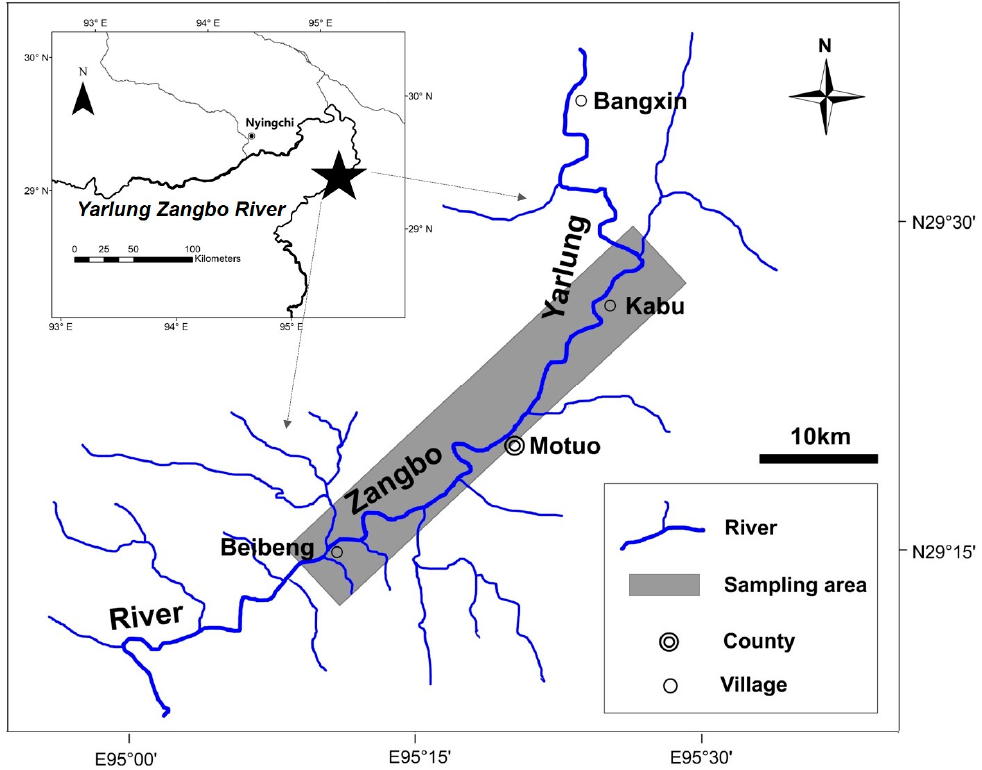
Figure 1. Location of the sampling area of Pseudecheneis sulcatus in the lower Yarlung Zangbo River from March to November 2016.